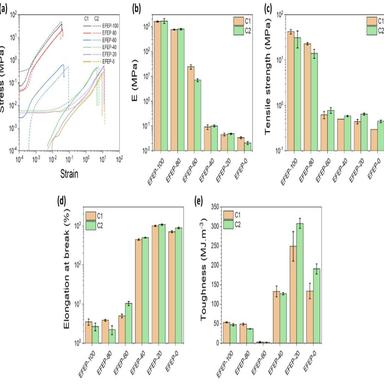
(a) Stress vs strain curves for specimens with original (C1) and reduced (C2) dimensions; (b) Comparison of the elastic modulus E for specimens with original C1 and reduced C2 dimensions; (c) Comparison of the ultimate tensile strength for specimen with original C1 and reduced C2 dimensions; (d) Comparison of the elongation at break for specimens with original C1 and reduced C2 dimensions; (e) Comparison of the toughness for specimens with original C1 and reduced C2 dimensions.